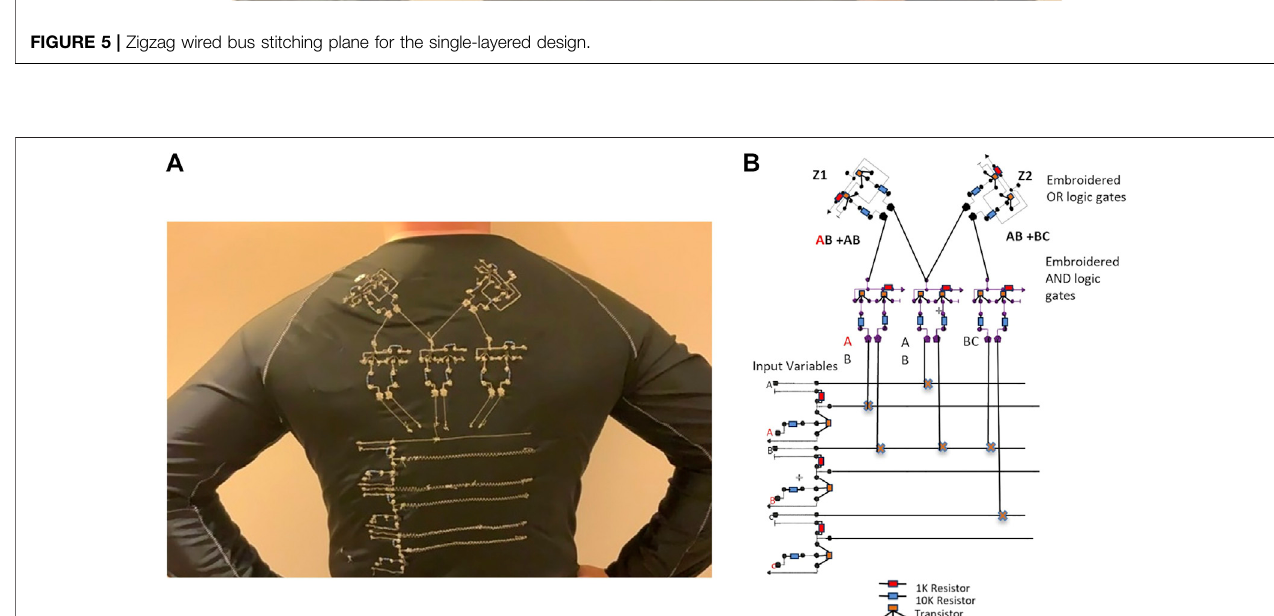
FIGURE 6 | Single-layered e-textile “ on the body edge worn computing ” PLA garment: (A) e-textile single-layered PLA garment design and (B) single-layer embroidered circuitry overview.